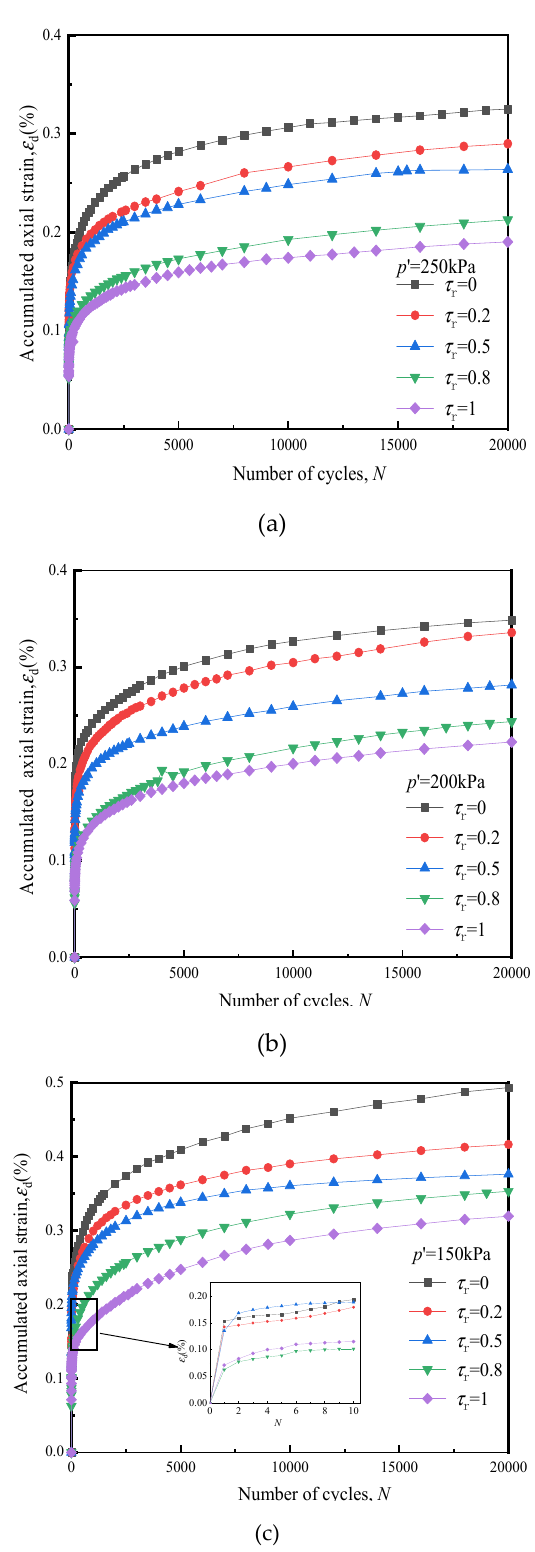
Figure 12. Influence of τ r on the development of ε d , ( a ) p ’ = 250 kPa, ( b ) p’ = 200 kPa, ( c ) p’ = 150 kPa.